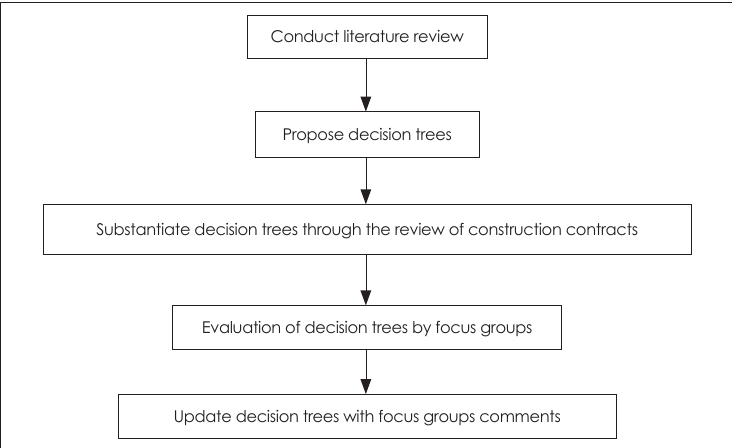
Figure 2: Action research process to develop a decision-tree support framework The first step in the action-research process was to conduct